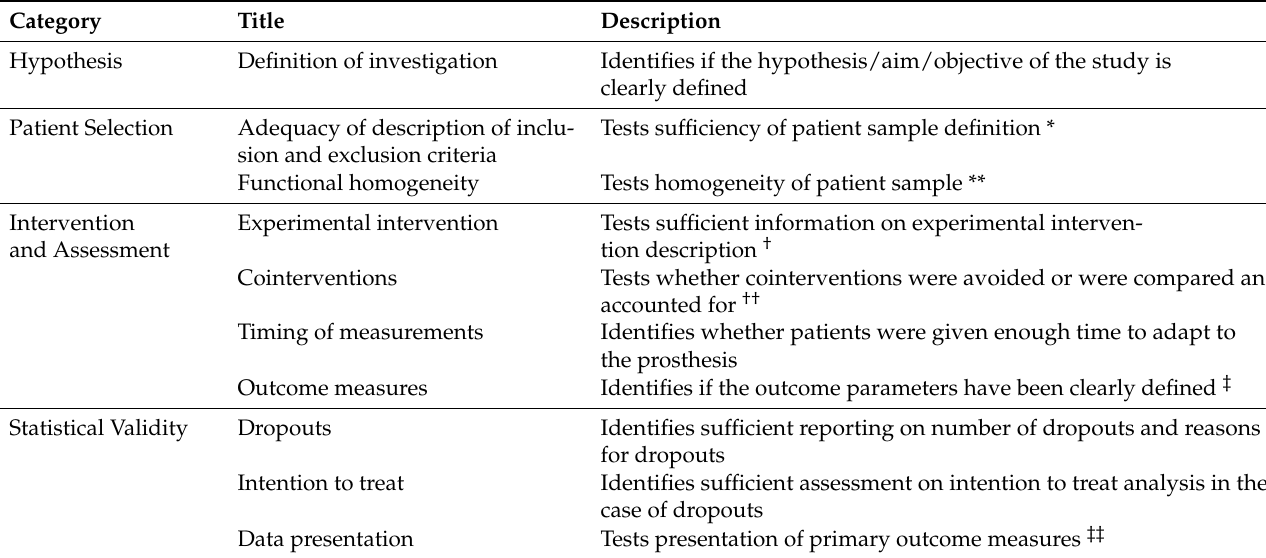
Table 2. Quality Assessment Table